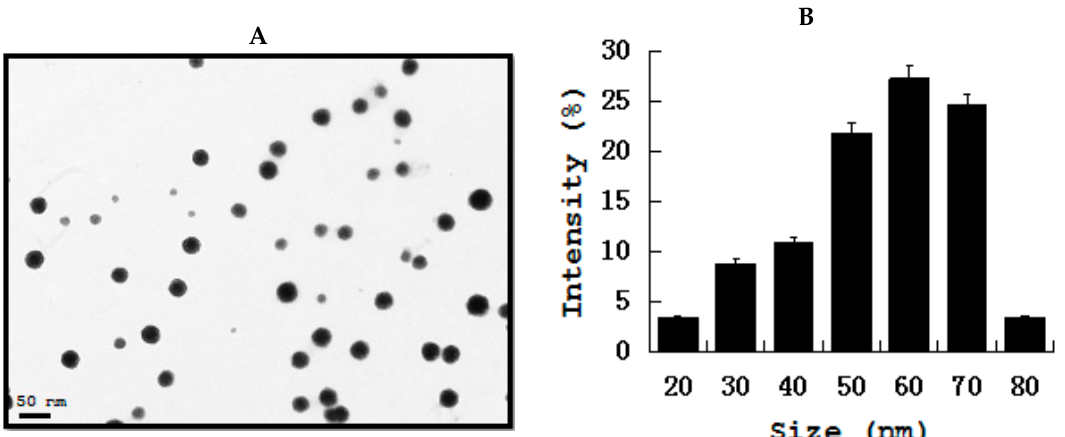
Figure 6. TEM of ZnO-NPs ( A ) TEM images of ZnO-NPs ( B ). Size distribution of ZnO-NPs from TEM images.